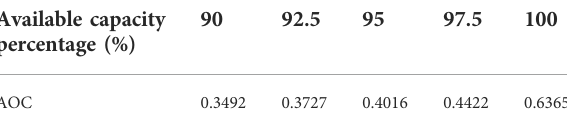
FIGURE 11 Descending order of hourly output (2200